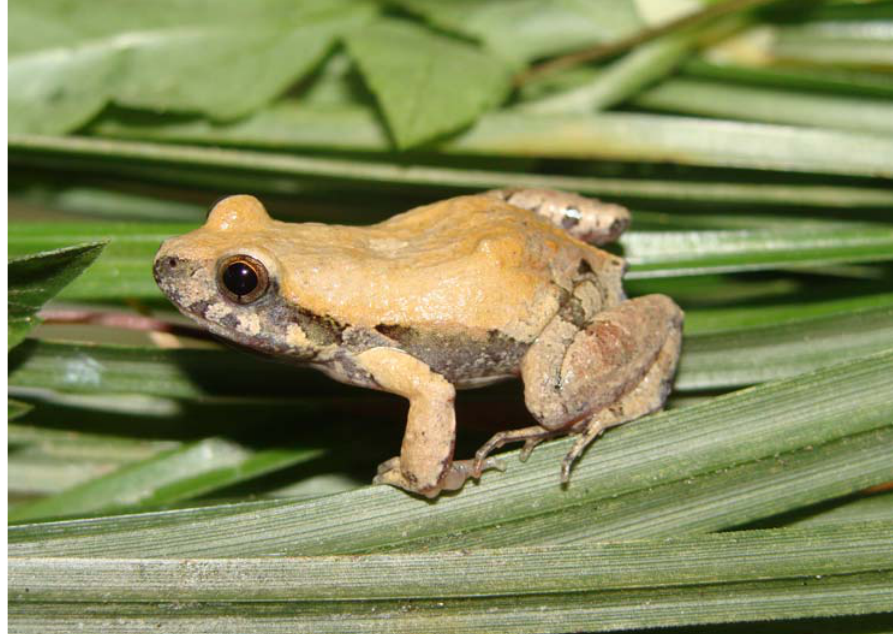
Figure 1. Adult male of Physalaemus cicada collected in the municipality of São José da Tapera, state of Alagoas, northeastern Brazil. Photo by B. S.